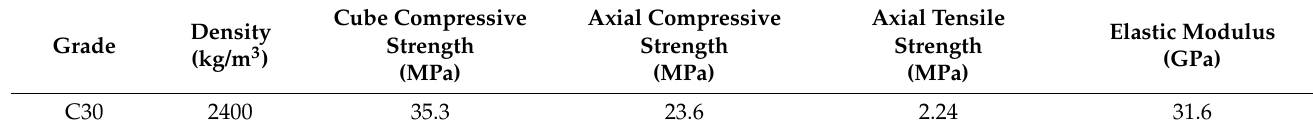
Table 6. Measured performances of concrete.